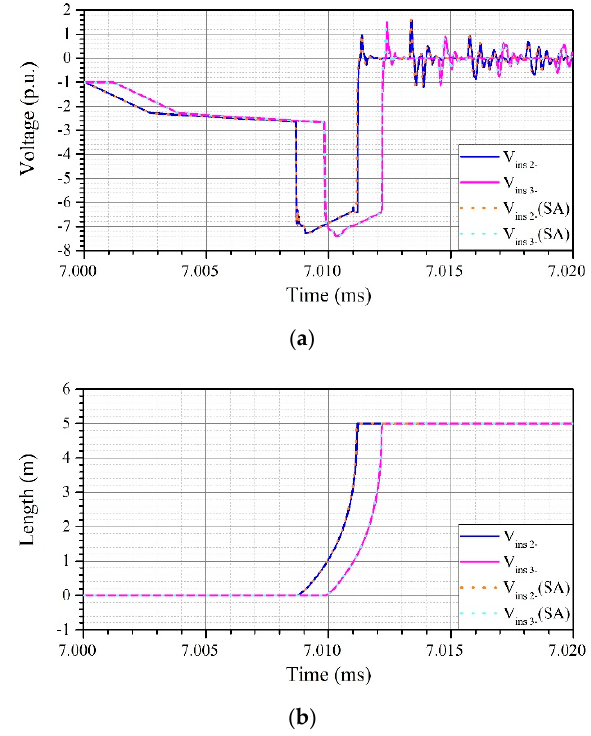
Figure 26. Lightning strike on the negative pole OHPC at twr 2S . ( a ) Voltage across negative pole insulators of twr 2S and twr 3S . ( b ) Leader propagation between insulator arc horns of twr 2S and twr 3S.